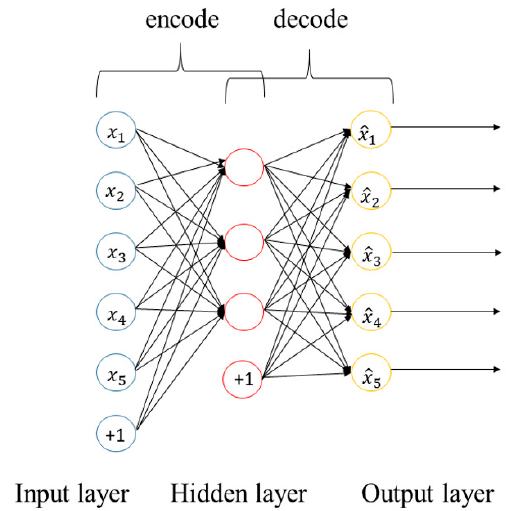
Figure 5. Conceptual diagram of